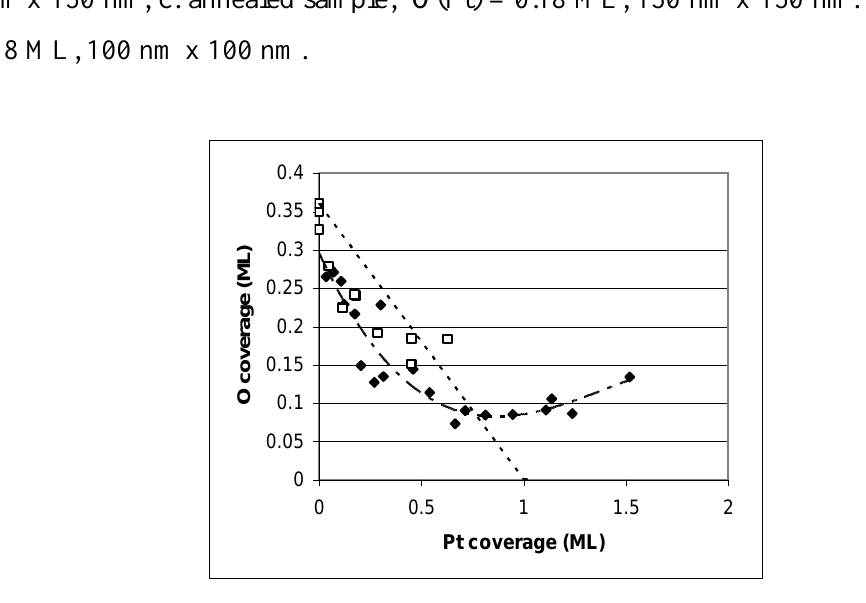
Figure 2. Evolution of the O 1s intensity after CO exposure versus Pt coverage. Empty squares: as- deposited Pt; Filled diamonds: annealed sample. The curve is a guide for the eyes. Broken line: see